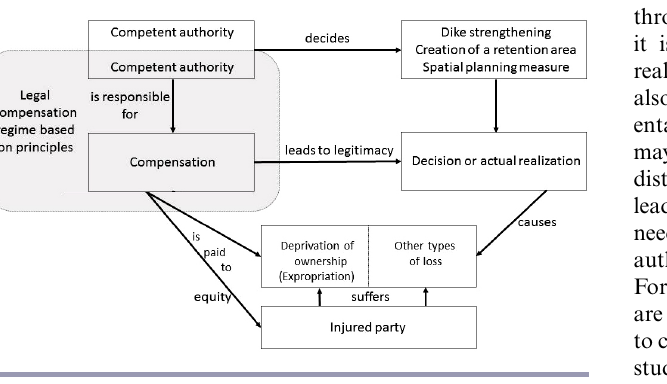
Fig. 1 . Envisaged relationship between main concepts